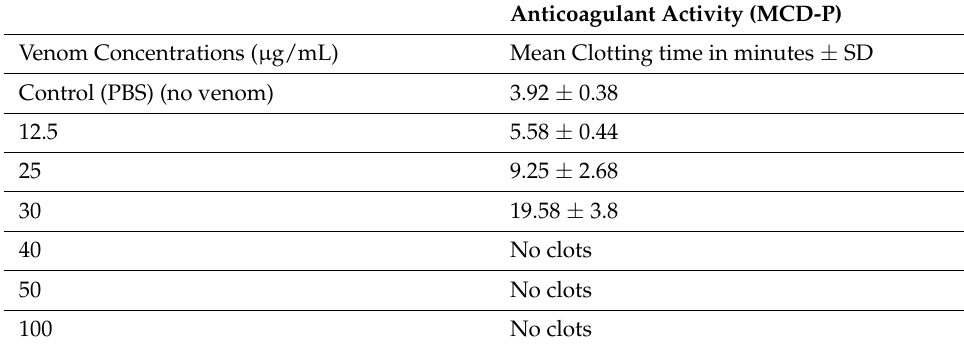
Anticoagulant Activity (MCD-P)